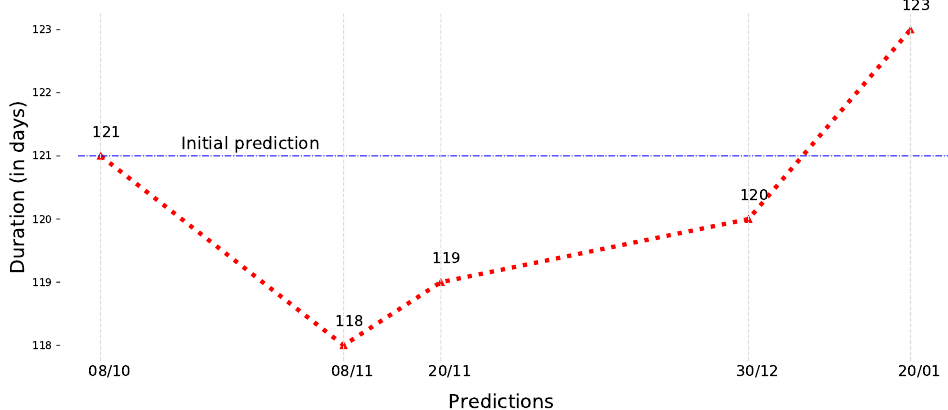
Figure 8. Dynamics of the predictions obtained with the PredHarv